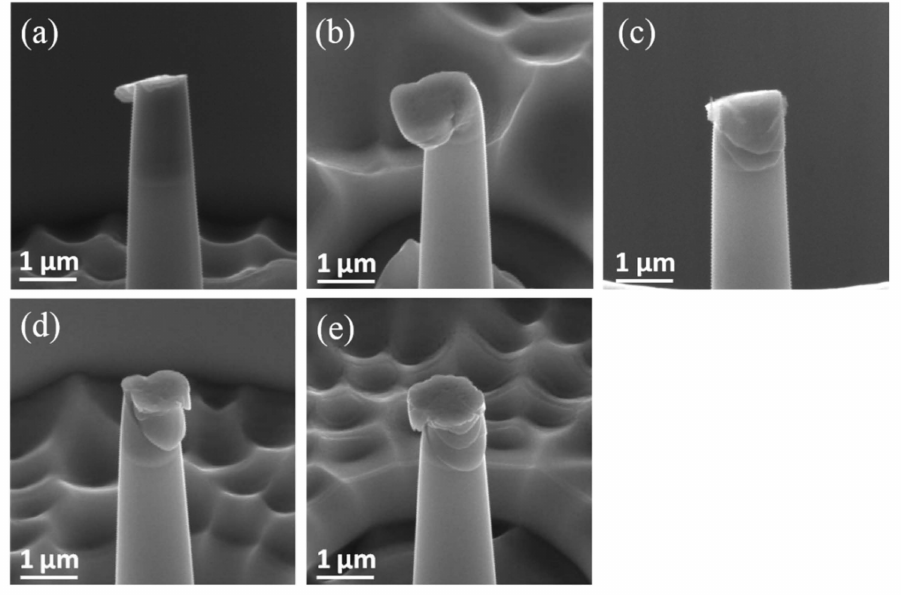
Figure 7. SEM images of as-compressed micropillars for ( a ) 0, ( b ) 0.6, ( c ) 1.8, ( d ) 4.1, and ( e ) 7.2 at.%